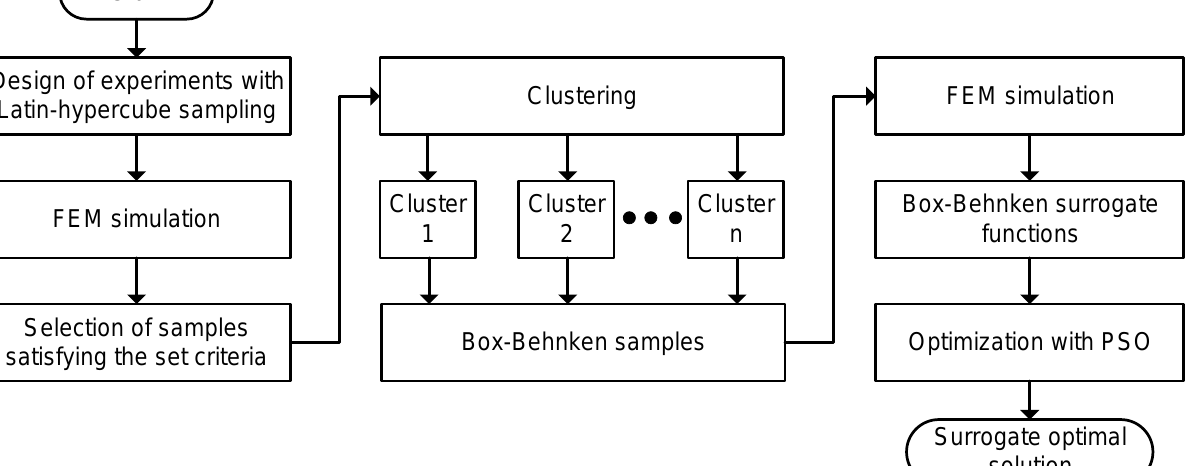
Figure 6. Flow chart: proposed optimization routine—part 1 (surrogate optimization).